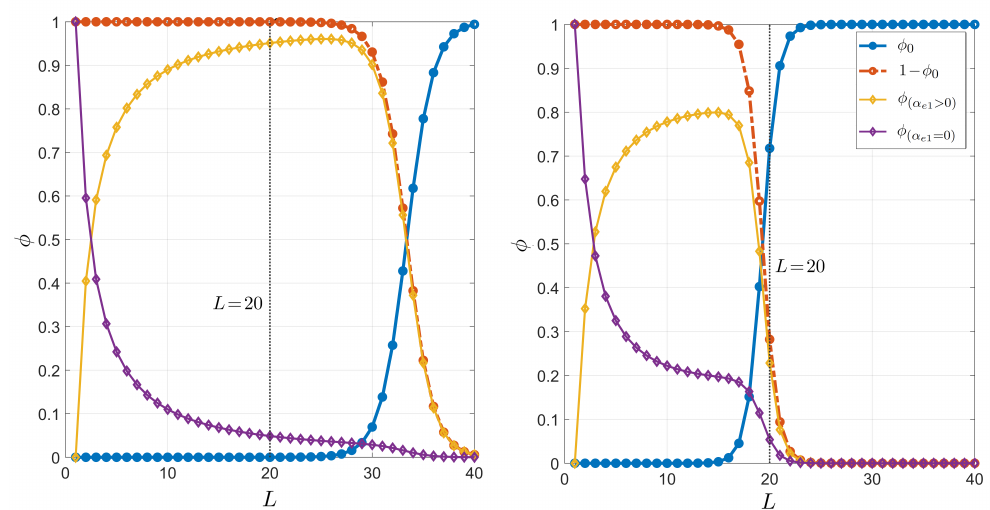
Figure A3. Dependence on the primer length L of the pairing probability for PCR. The plots are completely analogous to that shown in Figure 3 but with [ Na + ] = 55/4 mM ( left panel ) and [ Na + ] = 4 × 55 mM ( right panel